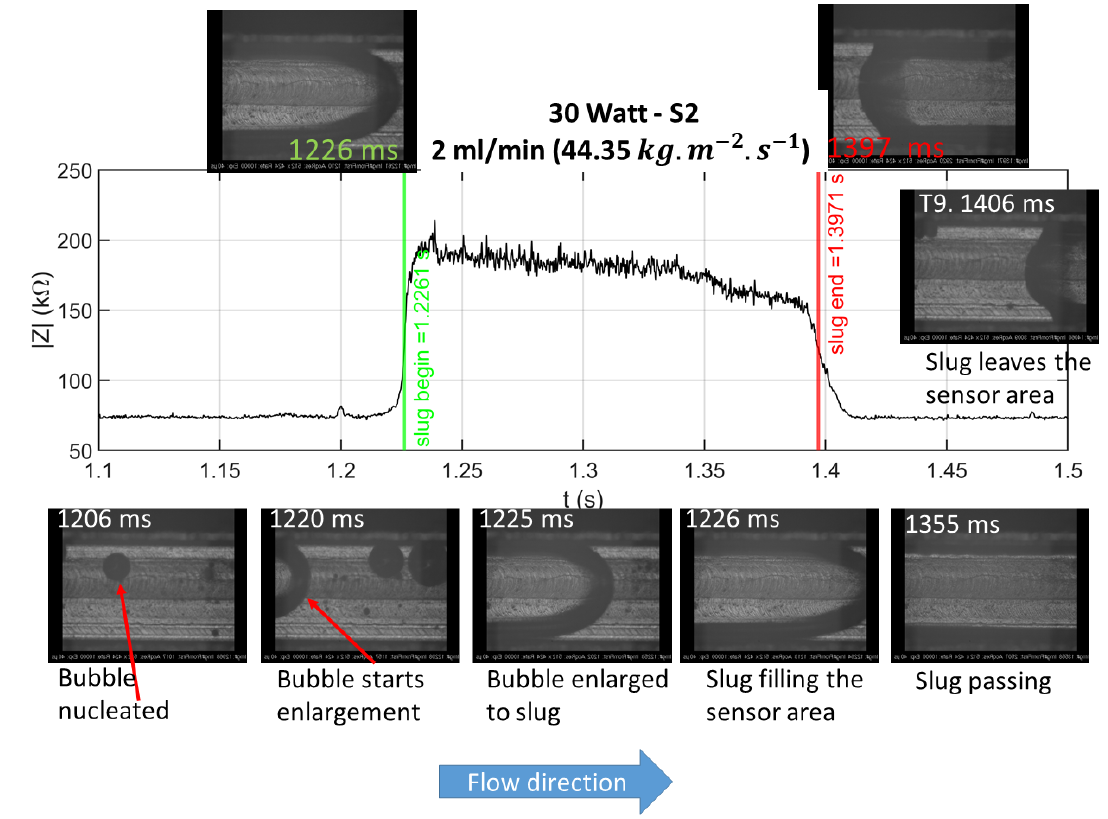
Figure 18. Example of synchronized recorded photos and impedance amplitude measurement. The green and red vertical lines are derived from signal post